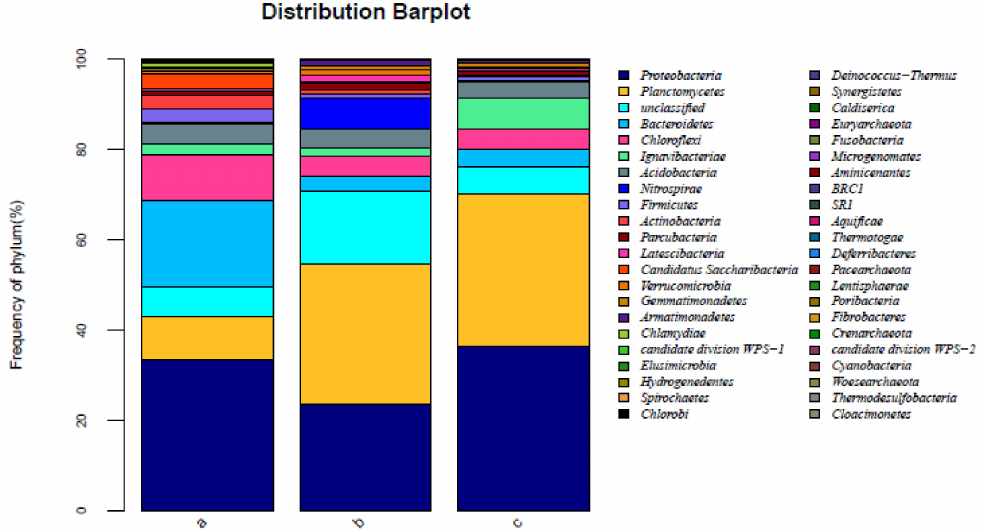
Figure 4. The phyla abundance of bacterial communities in a, b, and c samples. Samples a, b, and c were for seed sludge, ASBR sludge, and biofilter reactor sludge,